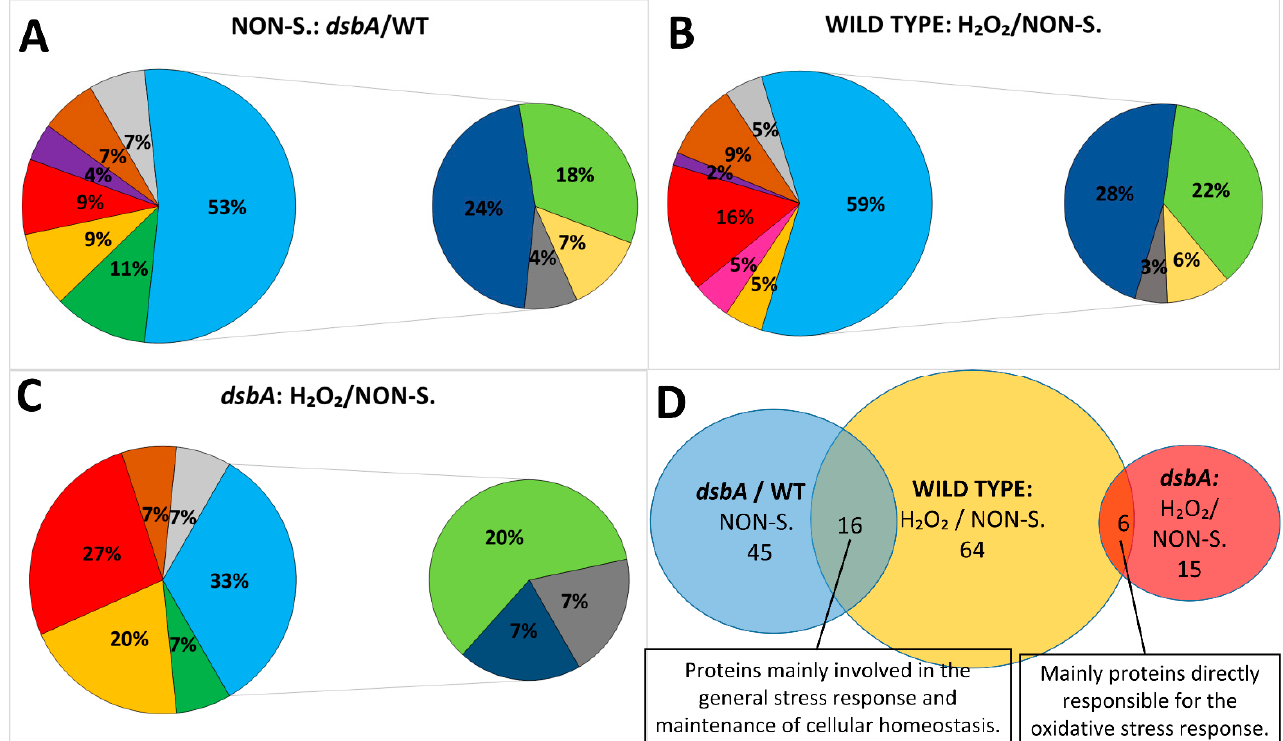
Figure 5. Graphic representations of proteomic data. ( A – C ) Functional categories and percentages of proteins whose levels were changed in the D. solani proteome due to ( A ) dsbA mutation, ( B ) oxidative stress or ( C ) in the D. solani dsbA mutant under oxidative stress. Areas in big circles: green: motility and chemotaxis; yellow: transport; red: stress response and protein quality control; pink: chaperones; purple: virulence and attachment; brown: lipoproteins, membrane and cell wall biogenesis; gray: others, unidentified; blue: metabolism. Areas in small circles: dark blue: general metabolism; green: protein synthesis; yellow: nucleotide and cofactors synthesis and homeostasis; gray: polyamine biosynthesis. ( D ) Diagram of unique and shared differentially expressed proteins identified in the proteome samples. Blue: proteins differentially expressed in the dsbA mutant compared to the parental wt D. solani cells, both grown under non-stressful conditions (NON-S.); yellow: proteins differentially expressed in the wt cells in the presence of the oxidant compared to the bacteria grown under non-stressful conditions; red: proteins differentially expressed in the dsbA mutant cells in the presence of the oxidant compared to cells grown under non-stressful conditions.